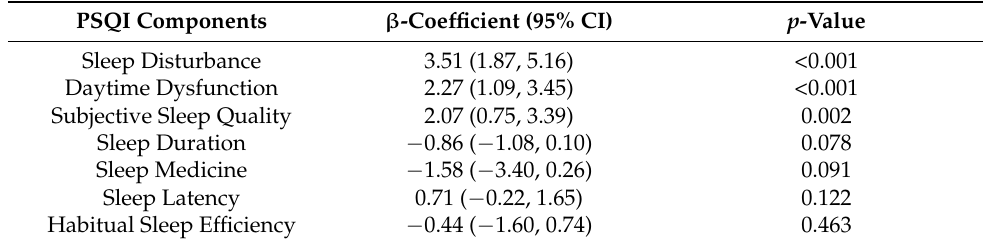
Table 4. Multiple Linear Regression to Determine the Influence of each PSQI component on PSS. PSQI Components β -Coefficient (95% CI) p -Value Sleep Disturbance 3.51 (1.87,